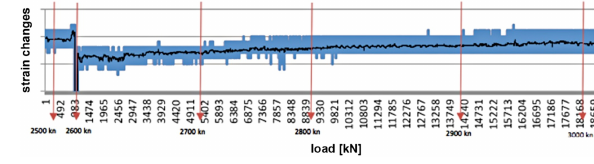
Figure 12: Results of the initial test of compression of bearing block: change of strain in function of compressive load increase.